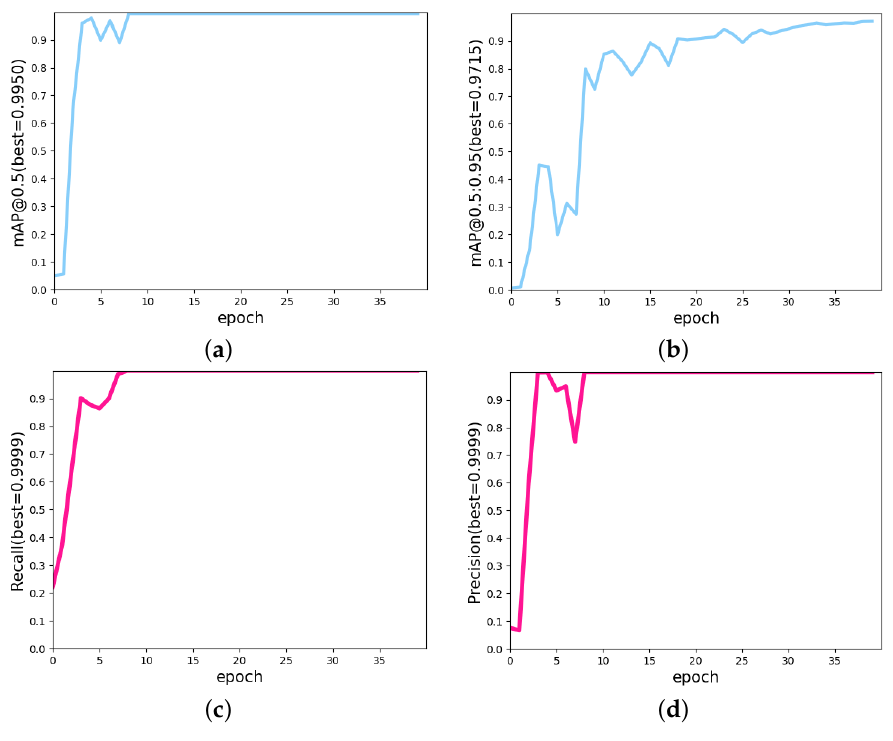
Figure 10. The metrics of the yolov5 change curve. ( a ) The curve of the change in mAP@0.5. ( b ) The curve of the change in mAP@0.5:0.95. ( c ) The recall change curve. ( d ) The precision change curve.